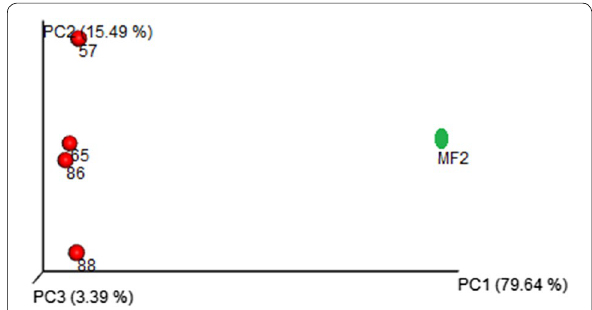
Fig. 7 Comparison of bacterial community of sa - um and Italian salami. All the representatives of Italian salami (Red) are far apart from the sa - um sample (green) in PCoA plot generated using the unweighted Unifac distance (57, 65, 86, 88 denotes fastq